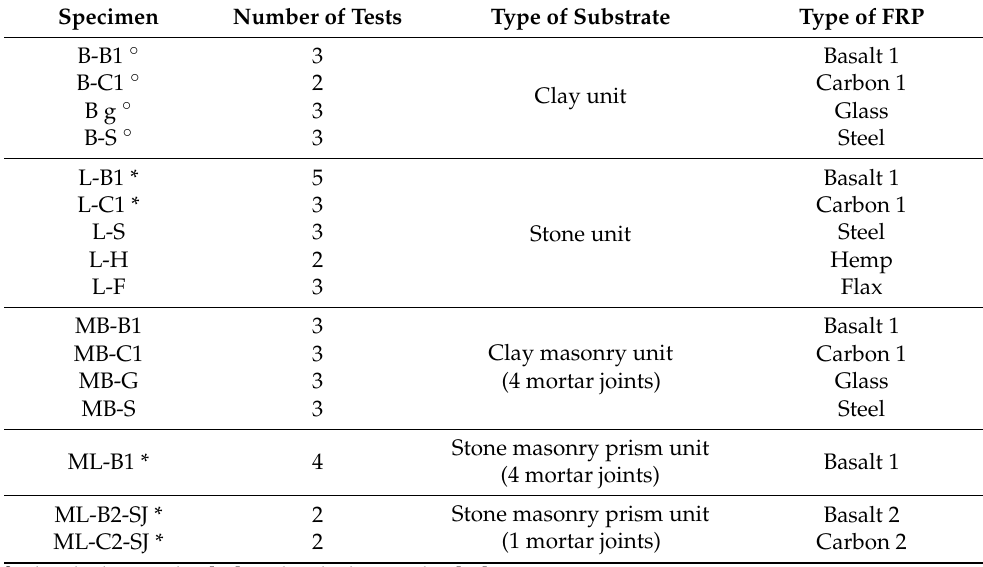
Table 3. Summary of specimens